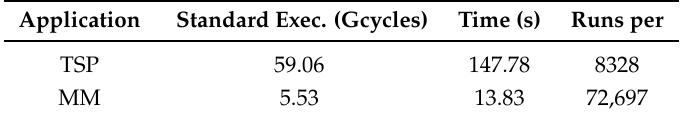
Table 3. Fault-injection campaign details of the 4MR-8Par applications running on the